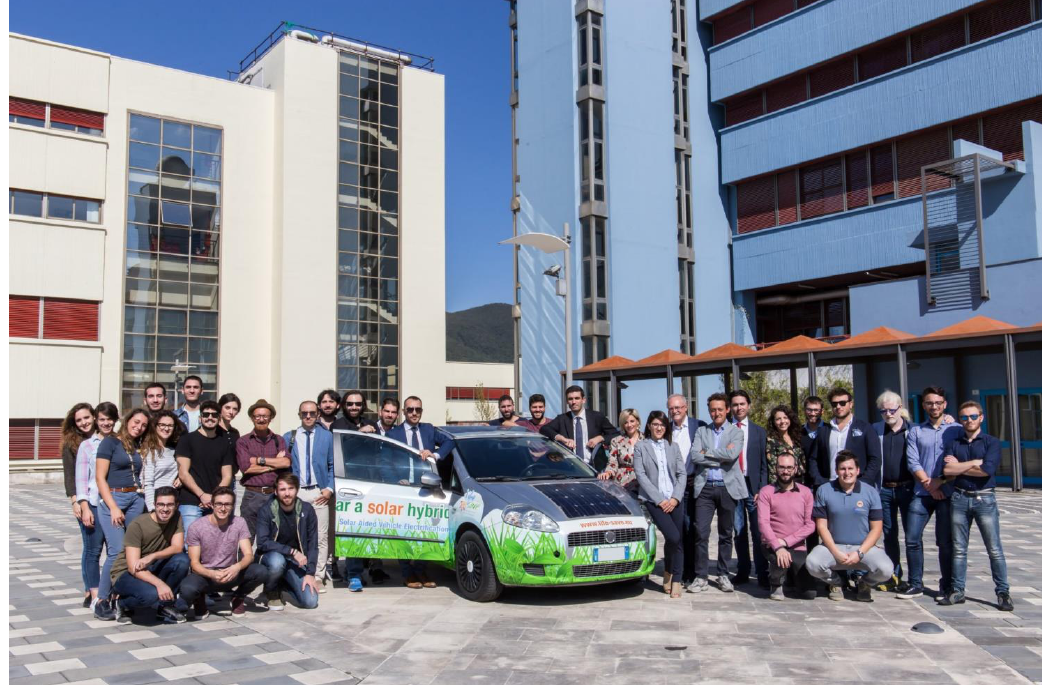
Figure 3. Hybrid solar vehicle prototype realized by the University of Salerno on a FIAT Grande Punto (https://www.life- save.eu/en/prototypes-team/, accessed on 1 October 2021).